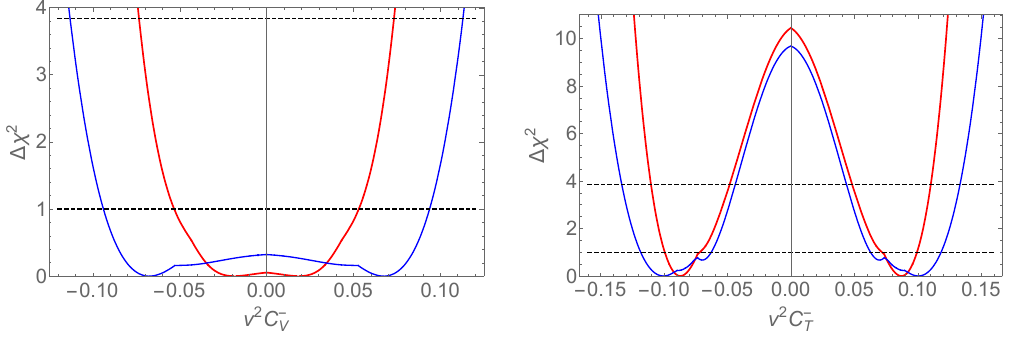
distributions for the Wilson coefficients C − min